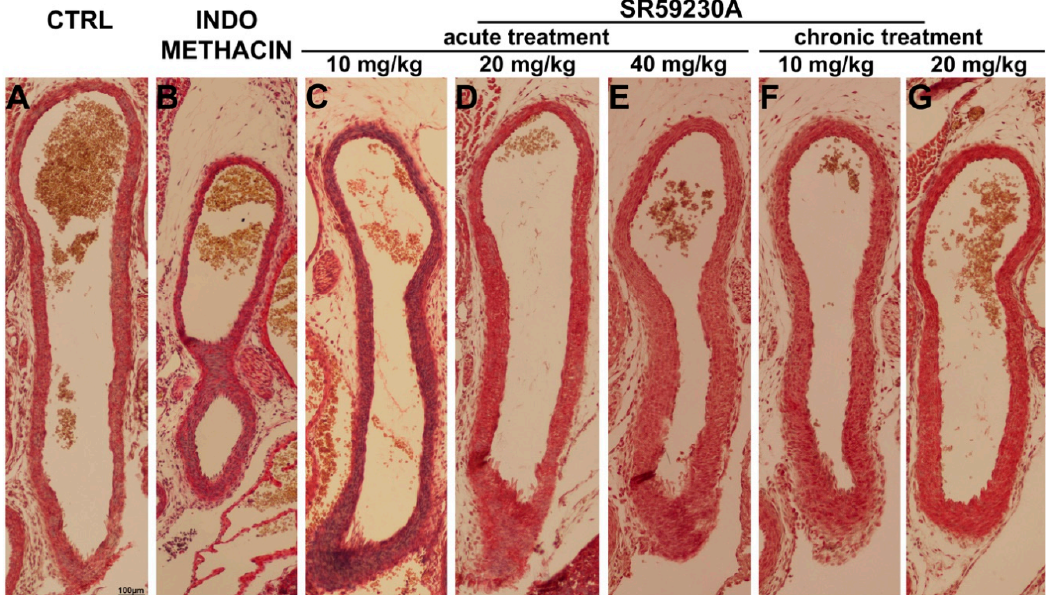
Figure 6. Morphological evaluation of the ductus arteriosus (DA) wall. Representatives pictures of Mallory’s trichrome stained sections of DA from fetuses of each experimental group ( A – G ). Compared with the CTRL, untreated animals, ( A ), both the treatment with 40 mg / kg SR59230A ( E ) or 5 mg / kg indomethacin ( B ) increased the overall thickness of SMC layers in the tunica media without a ff ecting collagen content. The treatment with SR59230A at 10 or 20 mg / kg did not alter the DA wall ( C , D , F , G ). Scale bar is indicated in panel A . At least 20 fetuses of 5 litters were evaluated for each experimental group and the results reported are representative of five independent